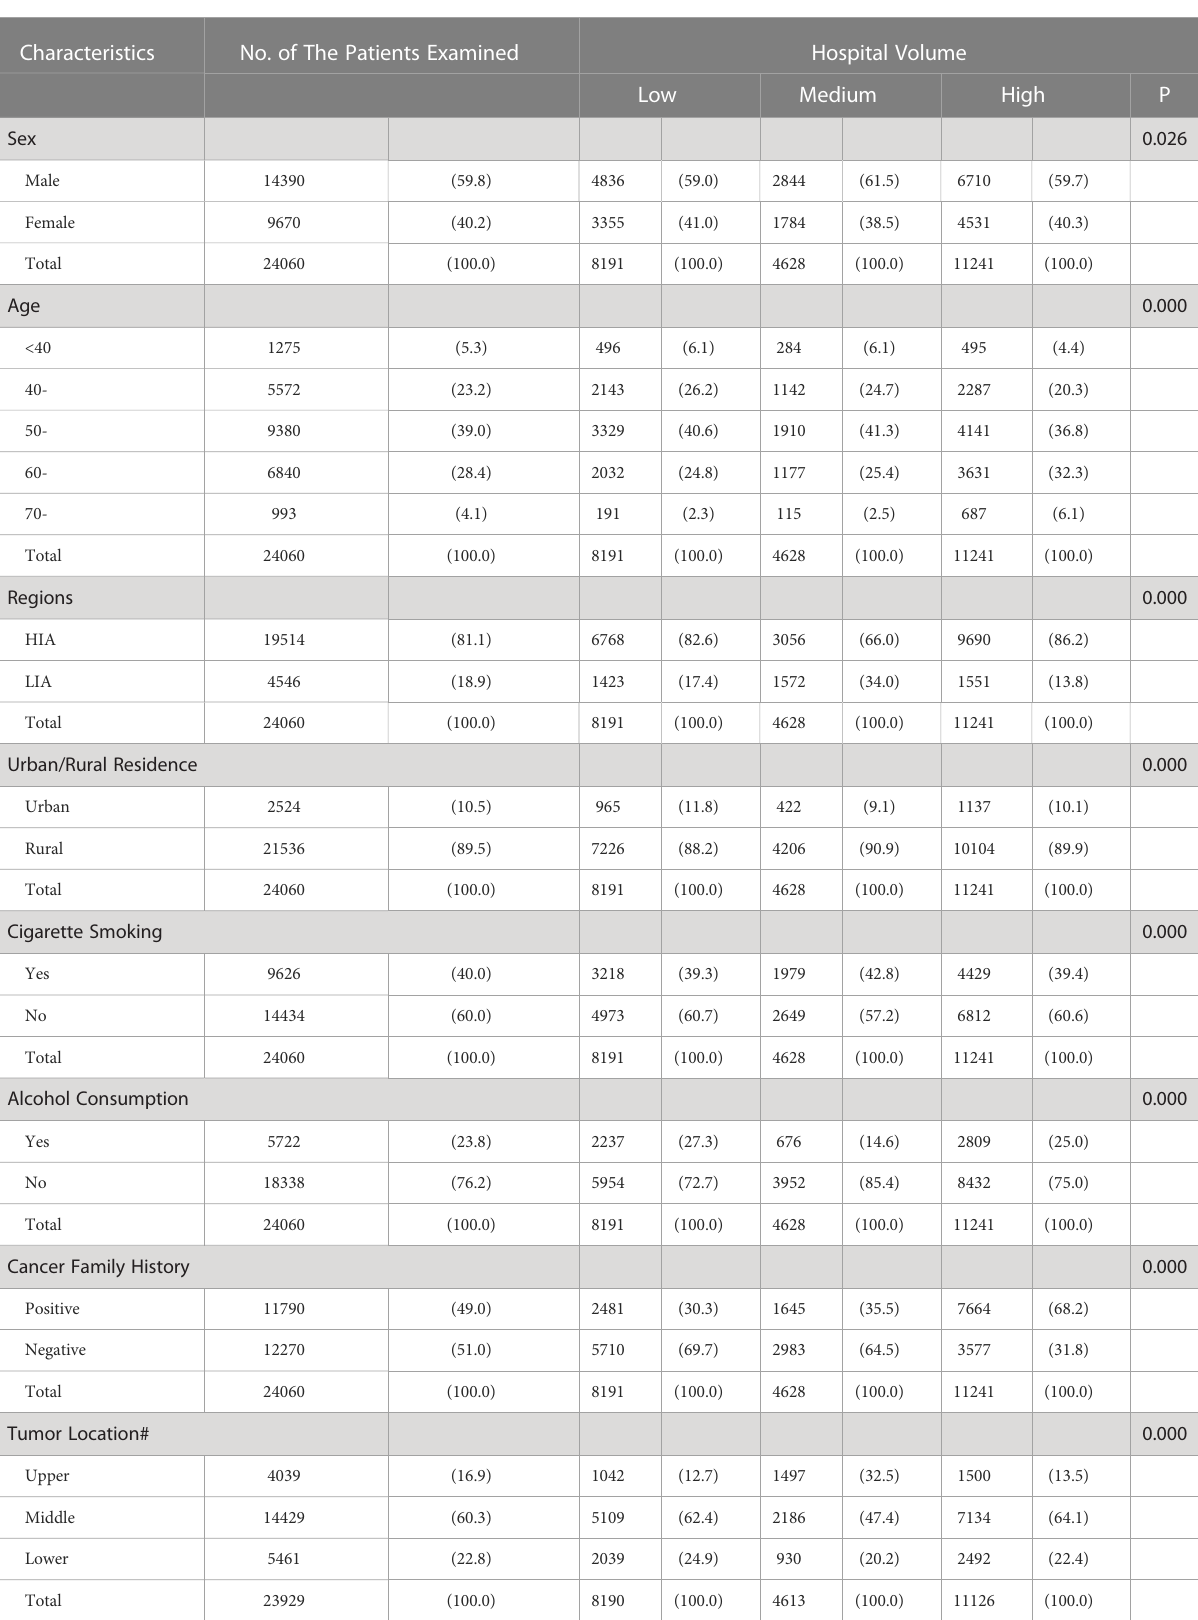
TABLE 1 Relationship between the clinicopathological features of ESCC patients and hospital volume during 1973-1996, n(%).